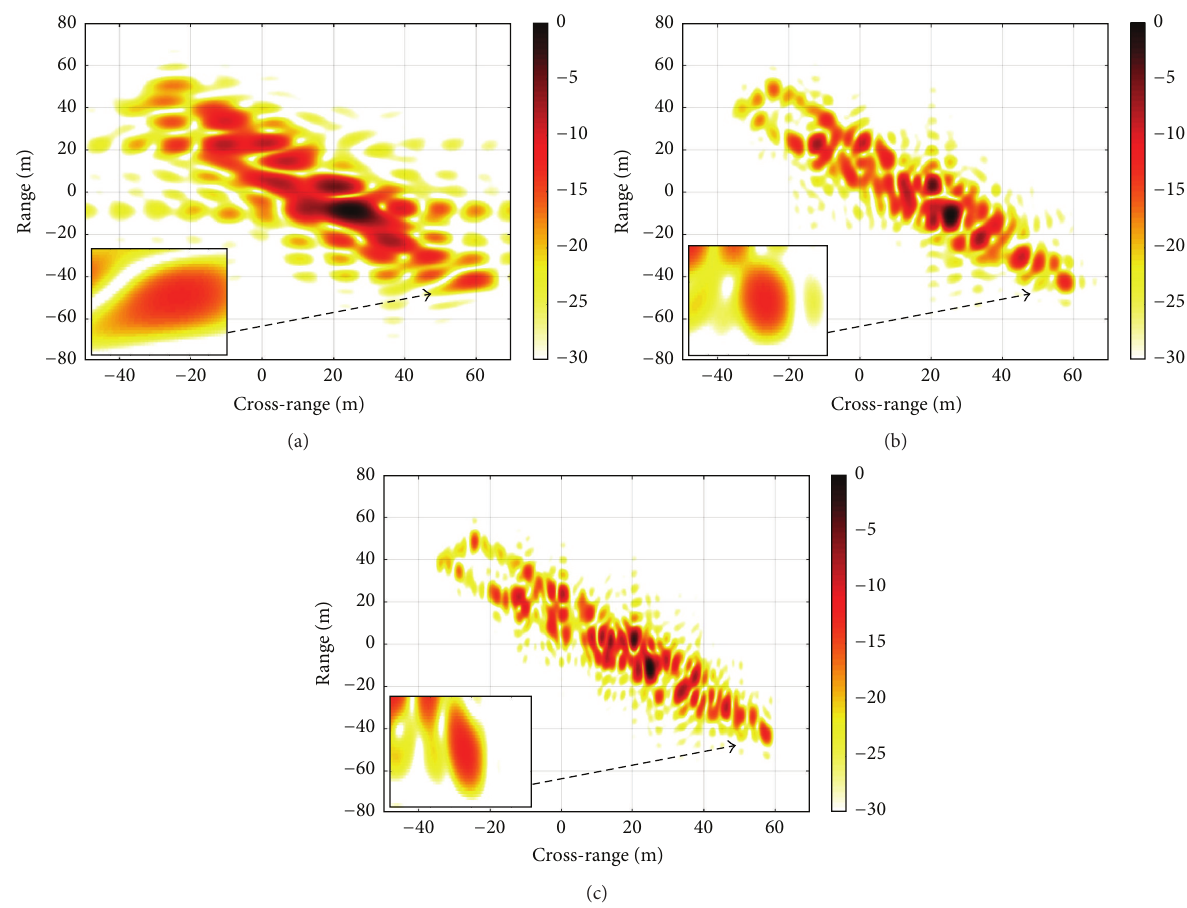
Figure 9: Single/multiscan ISAR images of the ship